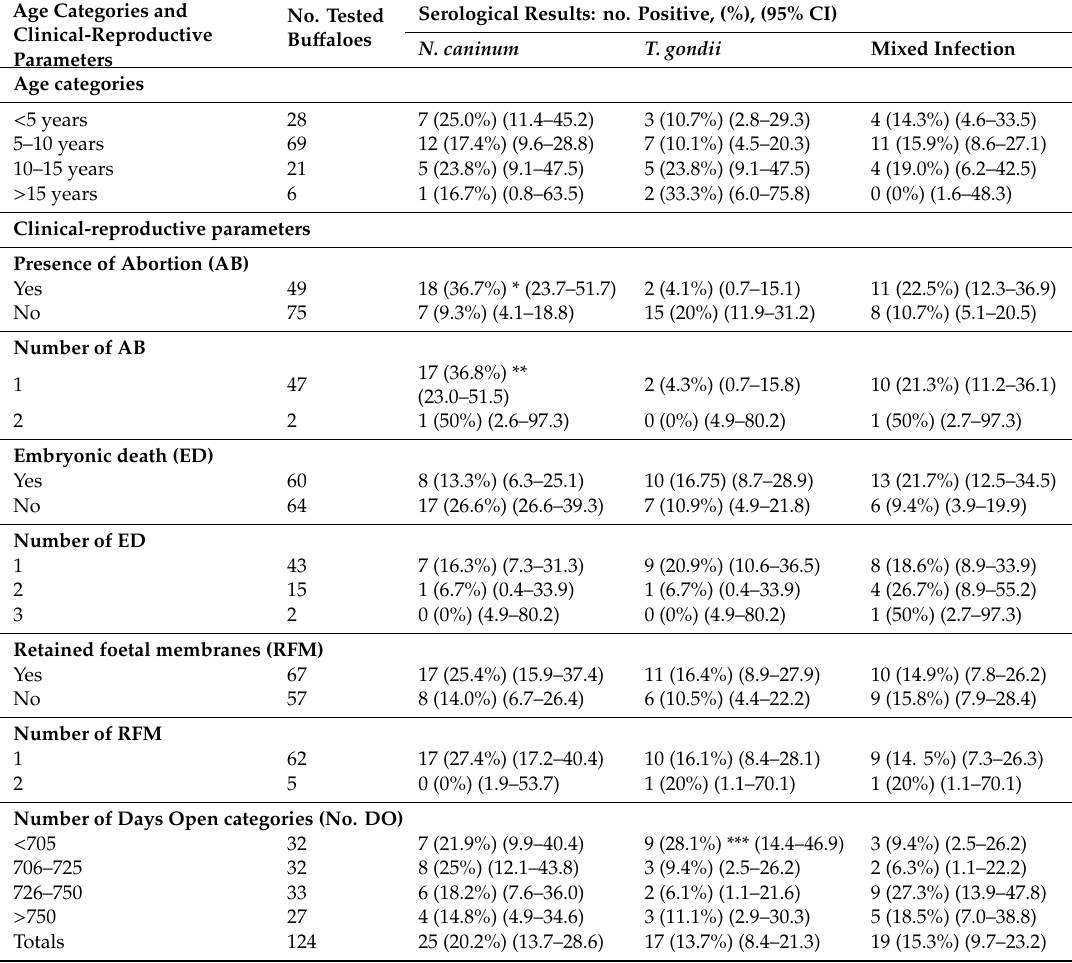
Table 2. Seroprevalences of N. caninum , T. gondii and mixed infection ( N. caninum and T. gondii ) in bu ff aloes based on age categories and the clinical-reproductive